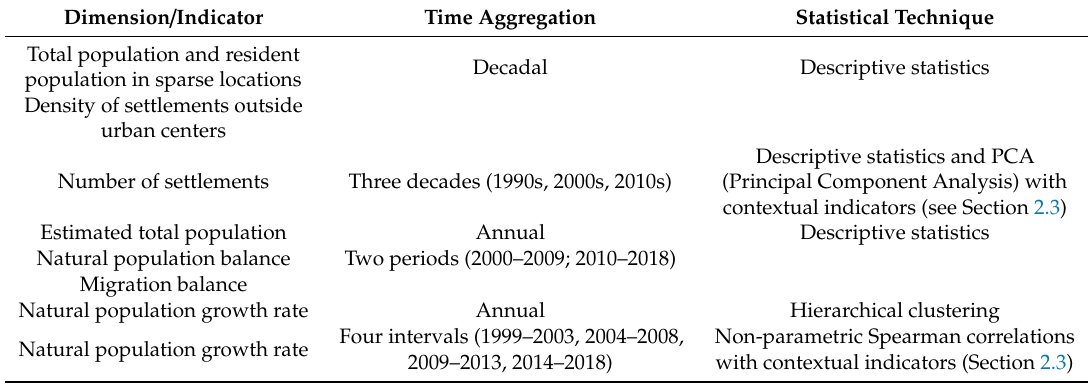
Table 2. A summary of statistical techniques run on the specific dimensions and indicators illustrated in Table 1 (descriptive statistics include tables, graphs and